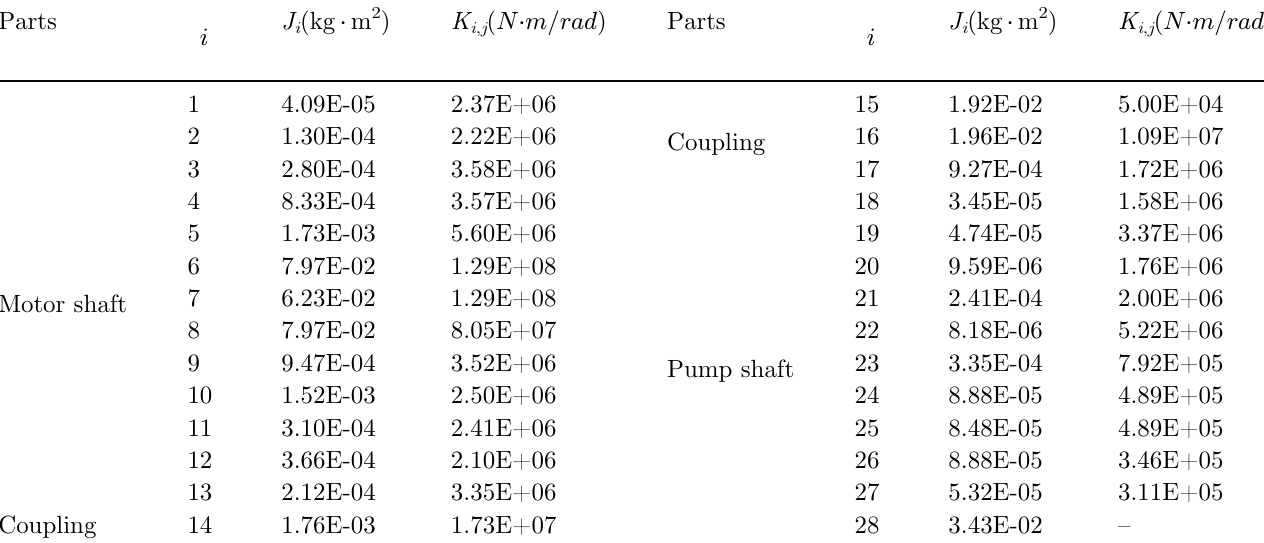
Table 3. Lumped parameters of the centrifugal pump shaft. Parts